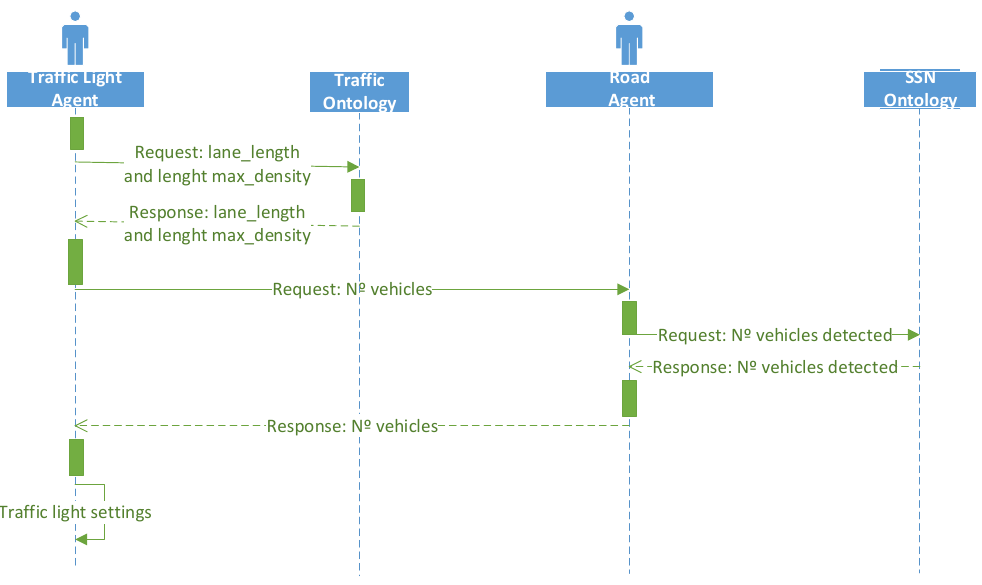
Figure 7. Sequence diagram of the traffic light adjustment task.